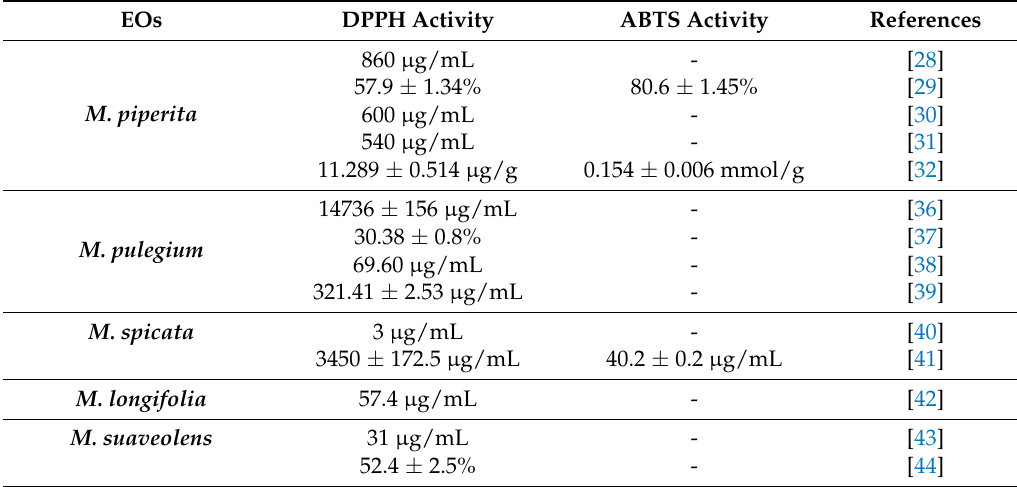
Table 1. Radical scavenging activity of Mentha essential oils (EOs). ABTS: 2,2’-azino-bis